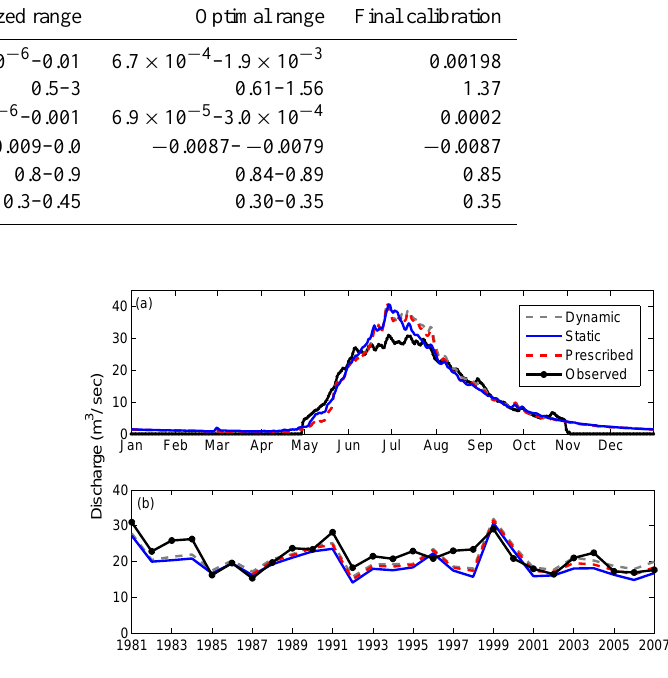
Fig. 8. Observed and predicted (a) mean annual daily (1997–2010), and (b) mean August discharge from model simulations using GDM, static ice and prescribed extent model configurations.